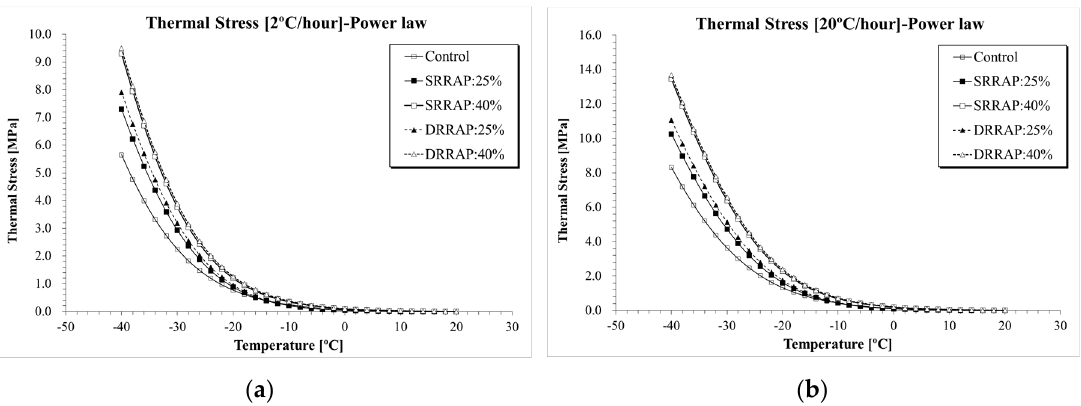
Figure 7. σ ( T ) computation results (Simple Power law): ( a ) 2 °C/h; ( b ) 20 °C/h.